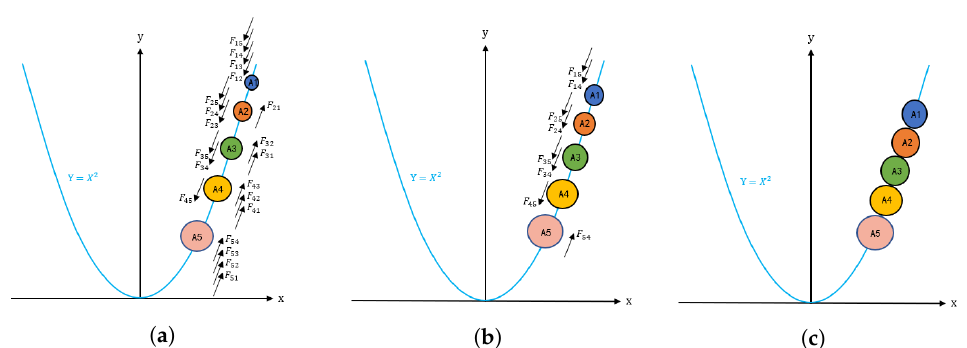
Figure 2. Movement behavior of agents in the GSA: ( a ) movement behavior of agents when kbest = 5; ( b ) movement behavior of agents when kbest = 2; ( c ) result of movement